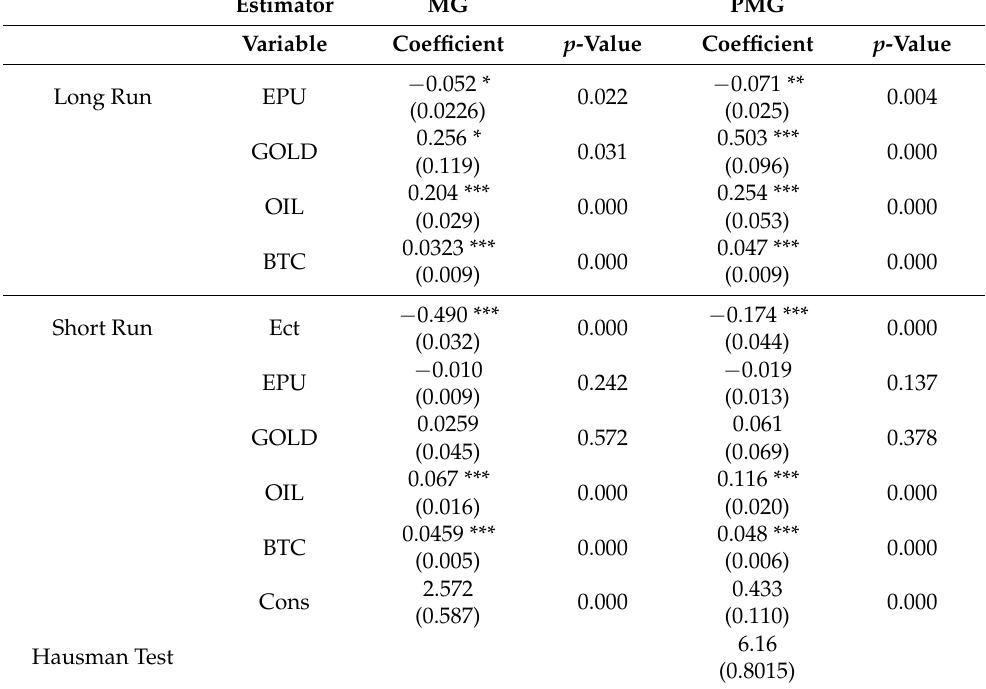
Table 6. MG and PMG estimation